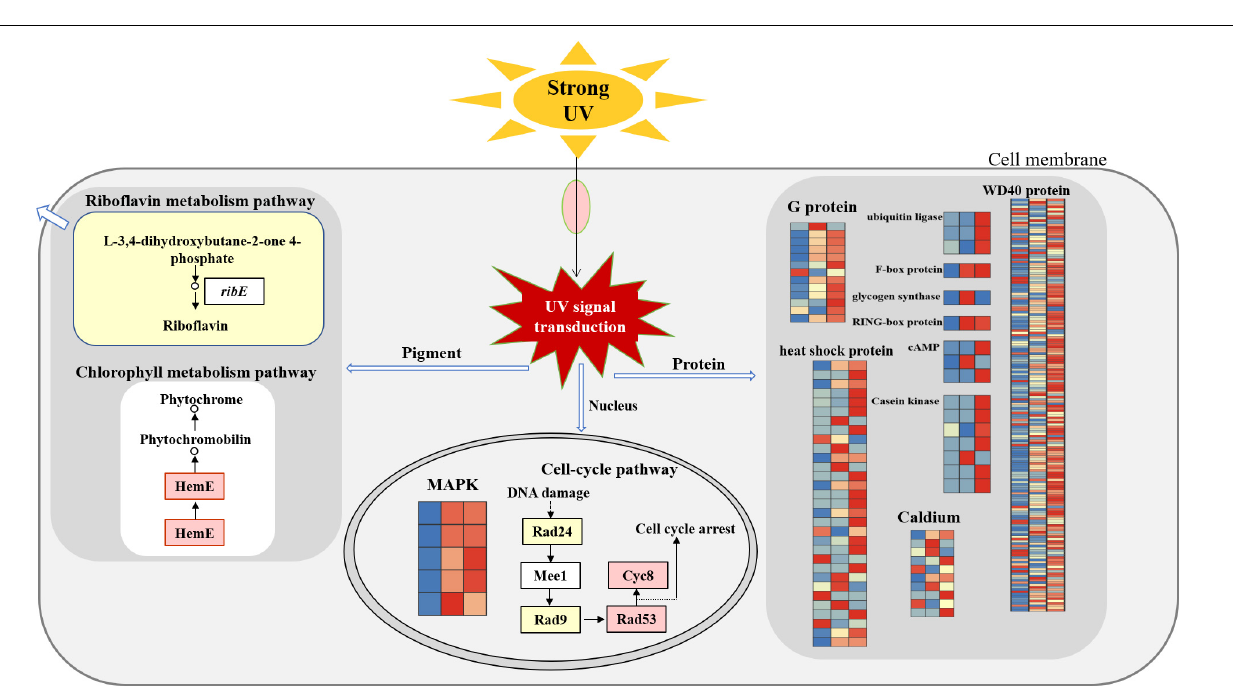
FIGURE 7 | The molecular regulation mode of F. luteovirens under UV